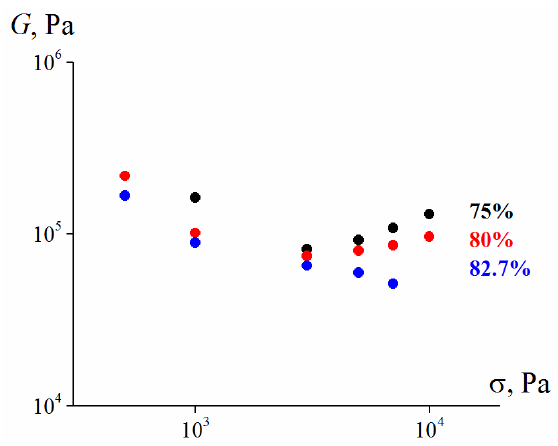
Figure 10. The dependence of the static shear elastic modulus on stress in suspensions with λ = 9.4 and the ratio of large and small particles of the solid phase equals to 25/75.